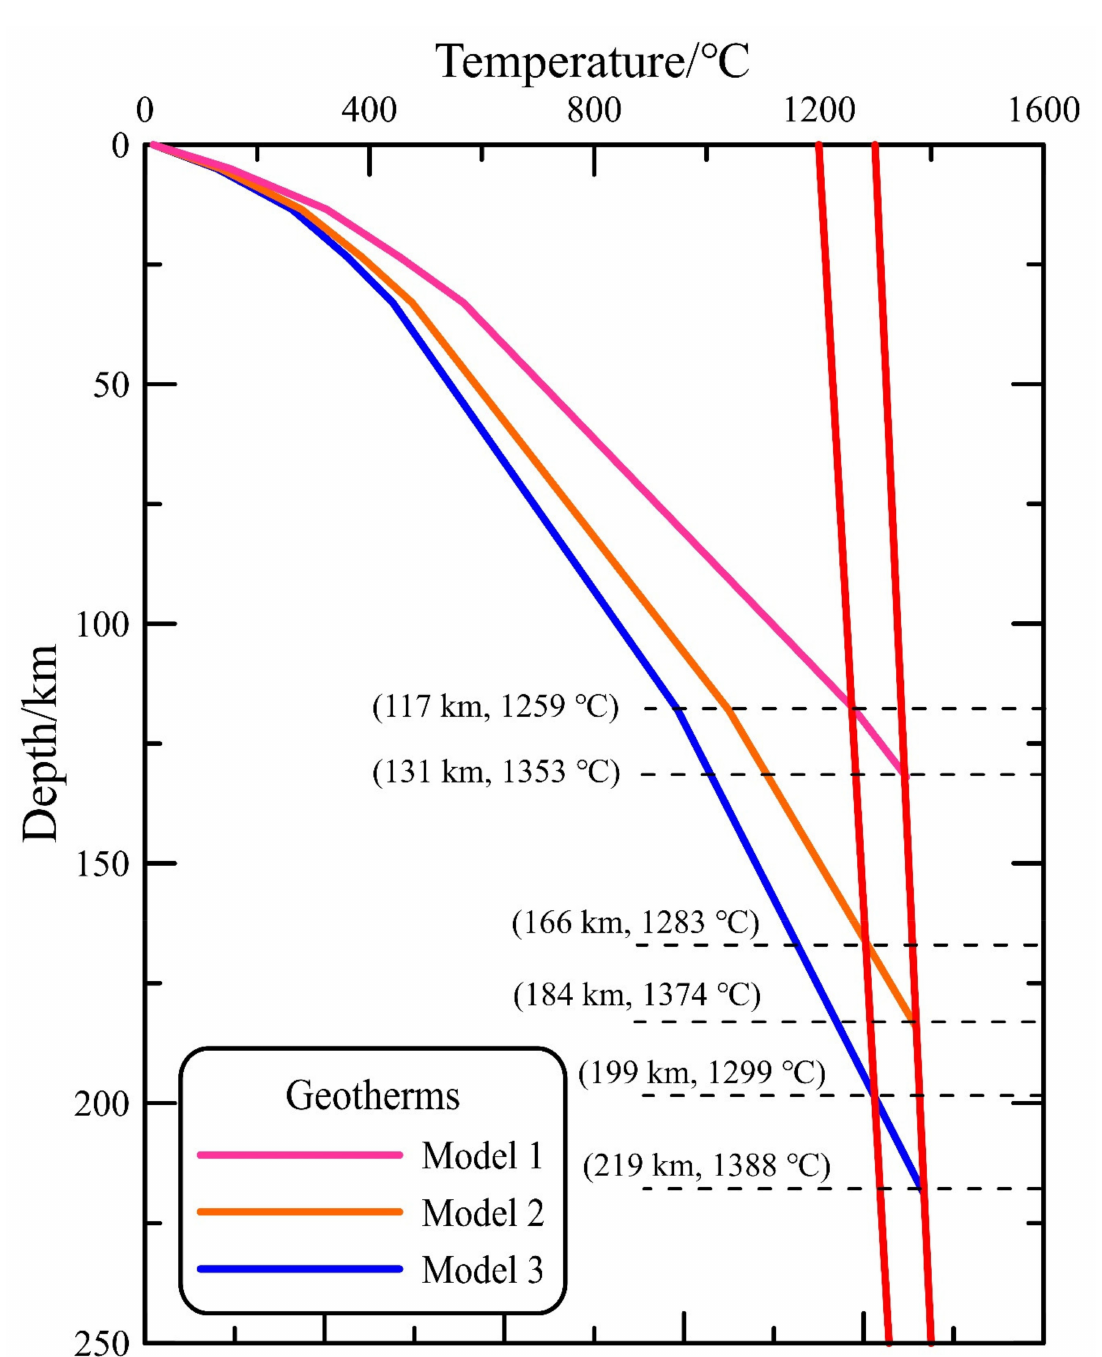
Figure 6. Geotherms map of the 3 different models. The red line shows the mantle adiabatic temperature